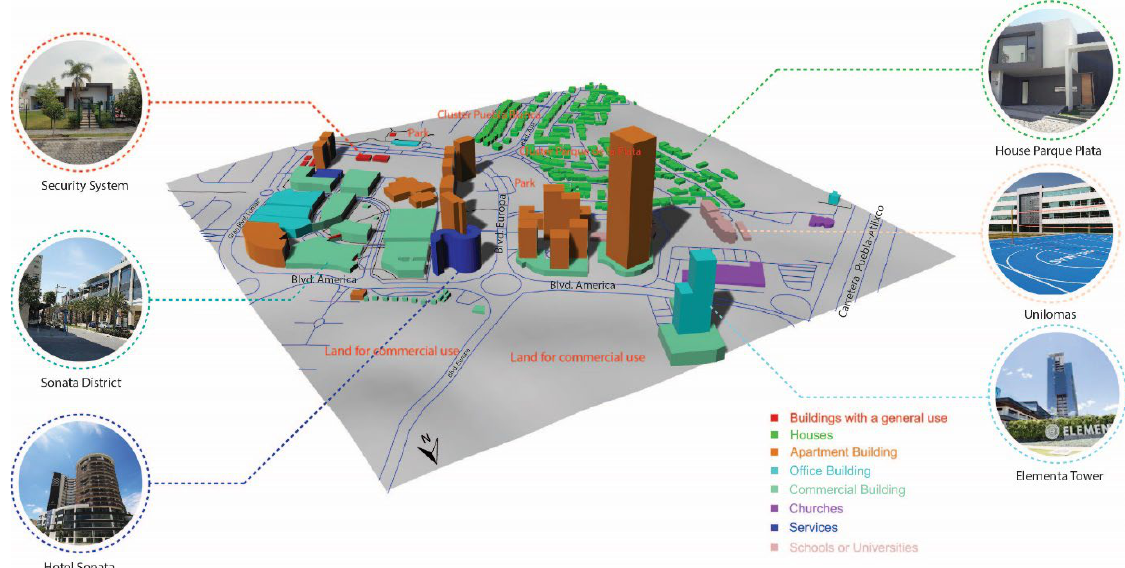
Figure 4. Model of the Sonata area, covering an extension of 1 km 2 around the urban heart of this zone. Elaborated by Edwin González M. (2022).